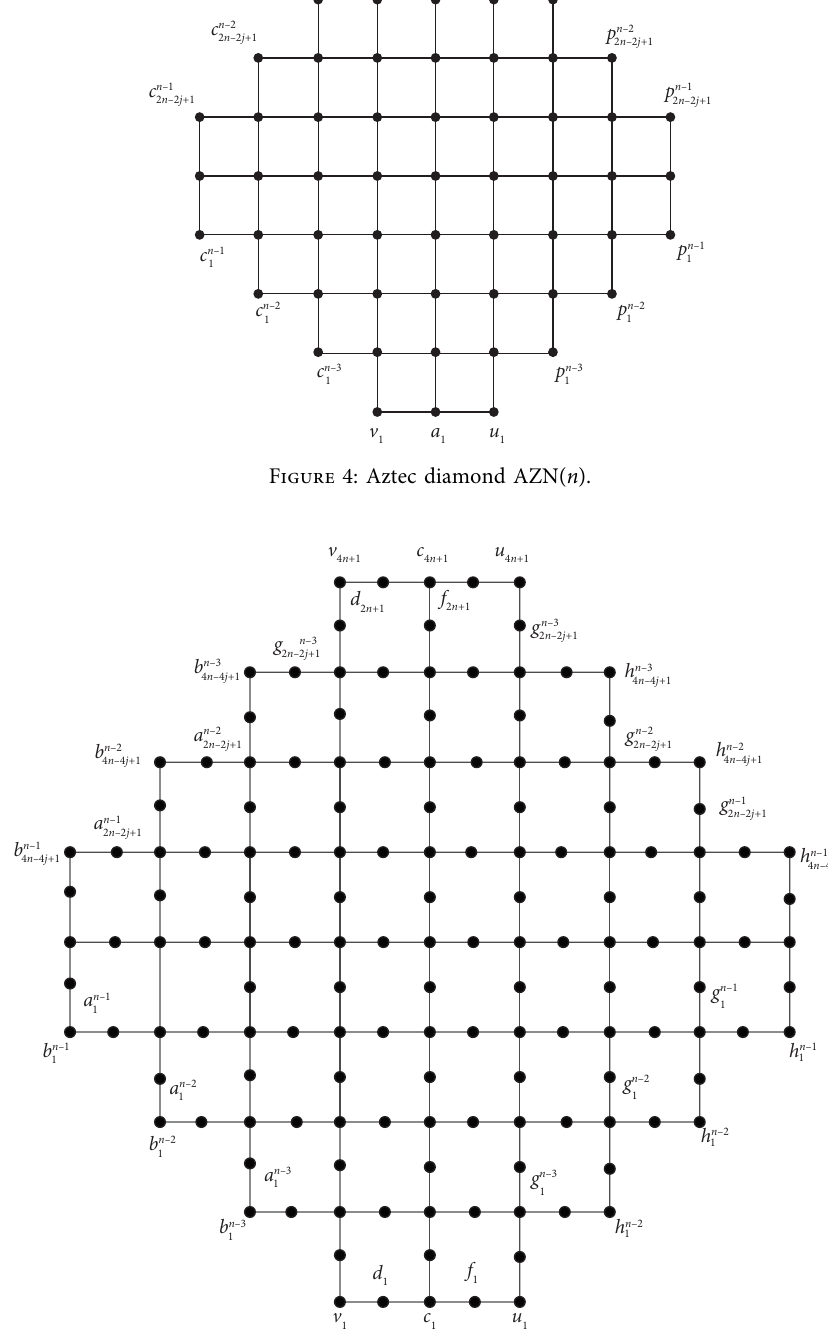
Figure 5: Subdivided SAZN( n ).